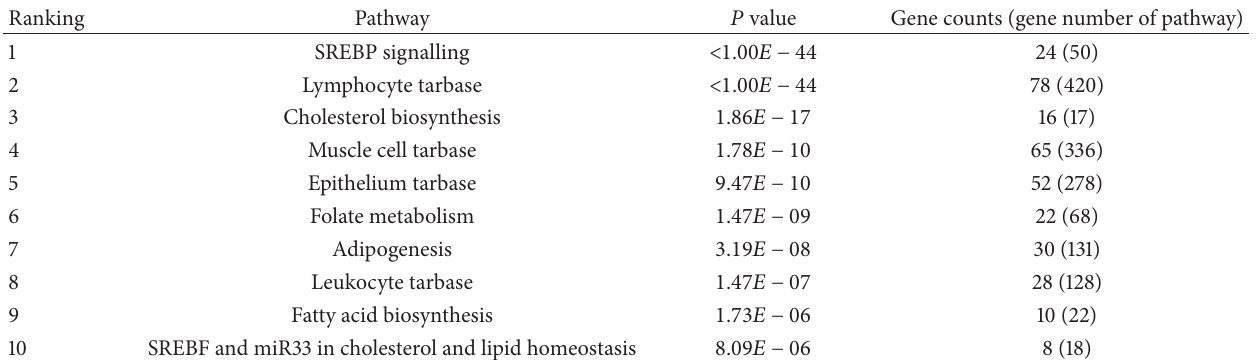
Table 5: The WikiPathways analysis selected gene sets significantly upregulated in MSX1 knockdown